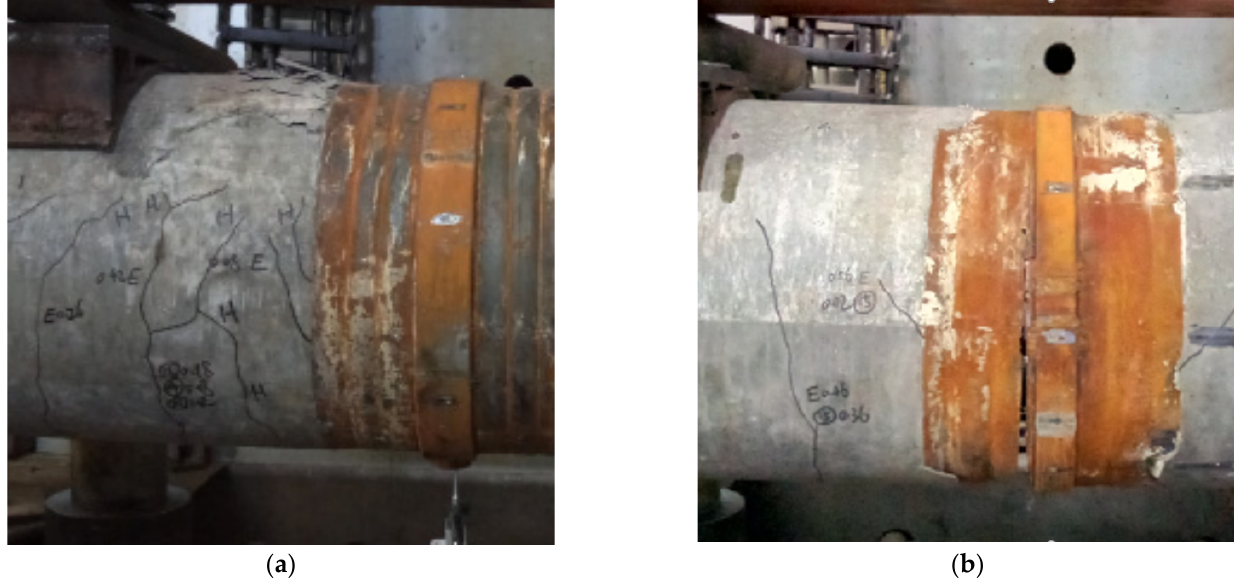
Figure 8. Failure modes of pile test specimen s : ( a ) concrete crushing; ( b ) anchorage failure.